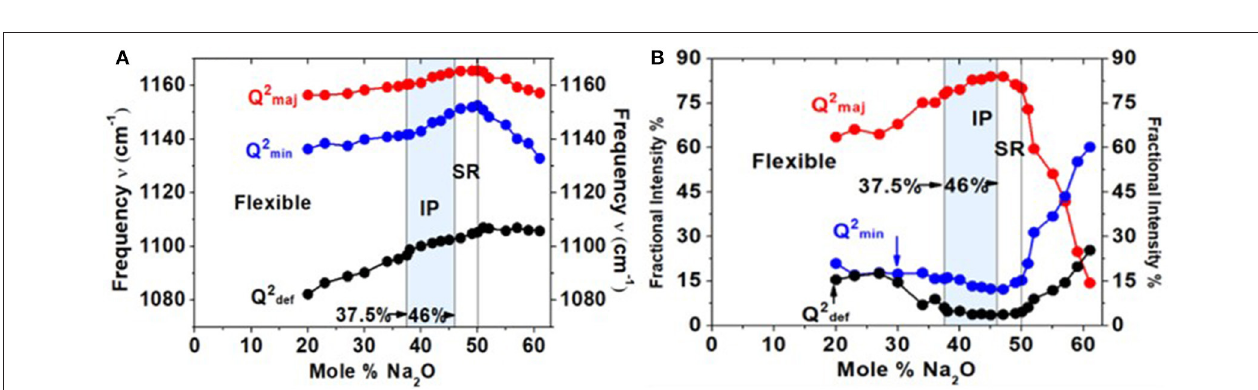
FIGURE 9 | Deconvolution of the triad of modes associated with feature 1 near 1,166 cm − 1 observed in the Raman scattering at x = 42% in (A) ; at x = 47% in (B) ; at x = 50% in (C) and at x = 57% in (D) . Also noteworthy in these spectra is the complete absence of a shoulder near 1,200cm − 1 noted by Hudgens et al. (1998) in Raman scattering of their glass samples in the 40% < x < 45% range.